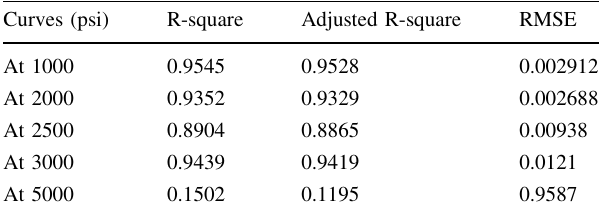
Table 2 Curve fitting and statistical measurements